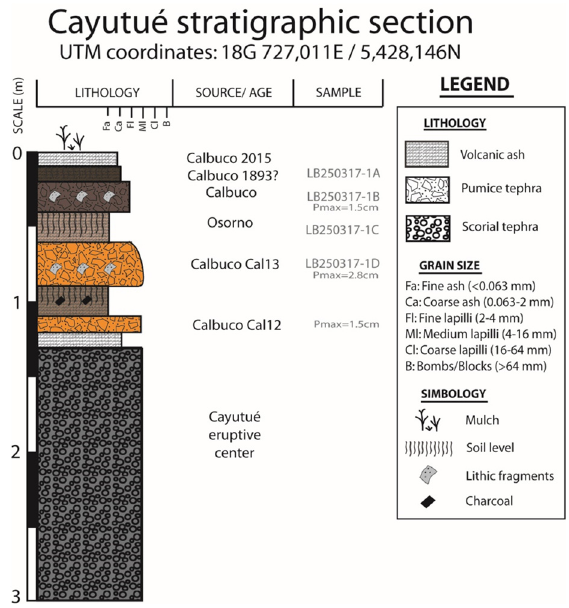
Figure 4. Stratigraphic section of the study site in the Cayutué forest with tephra deposits. The fieldwork was done during March 2017 by sampling 15 trees, with 2 cores per tree of healthy dominant F. cupressoides individuals, utilizing increment borers of 5 mm in diam- eter. Core samples were prepared following standard dendrochronological techniques